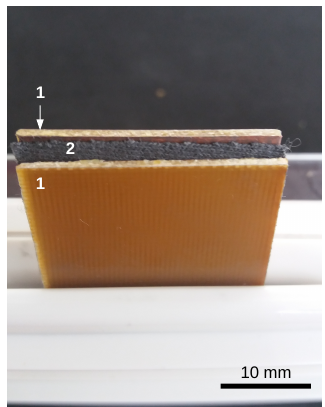
Figure 2. The electrical device ED. 1-textolite plates; 2- hMACs or hEMACs.